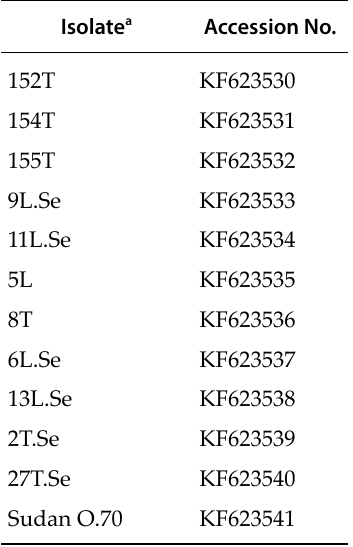
Table 2. Identification code and GenBank accession num - bers of the OYDV-O isolates from the Tropea area in Calabria (southern Italy) and the OYDV-O isolate from Sudan.